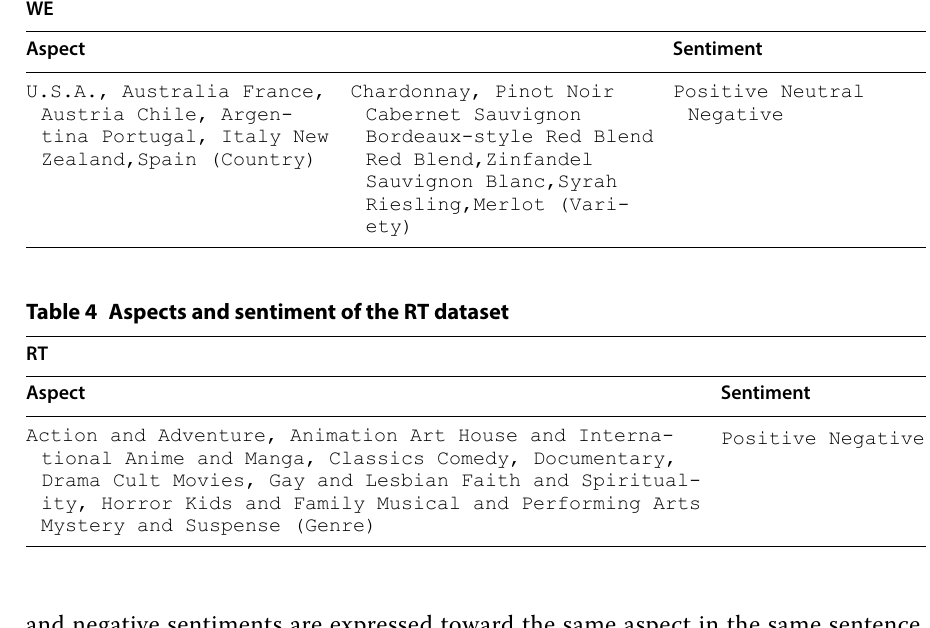
Table 3 Aspects and sentiment of the WE dataset WE Aspect